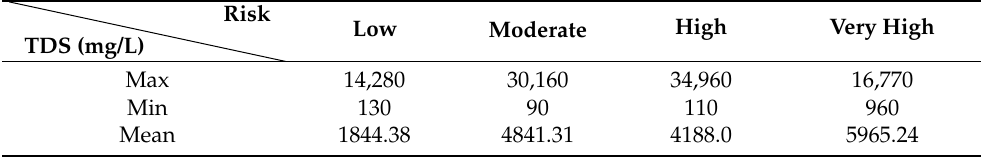
Figure 5. The spatial distribution of TDS content and Mod-DRASTIC vulnerability categories in the study area. Table 6. Analyzing TDS concentrations on the salinization risk map in the study